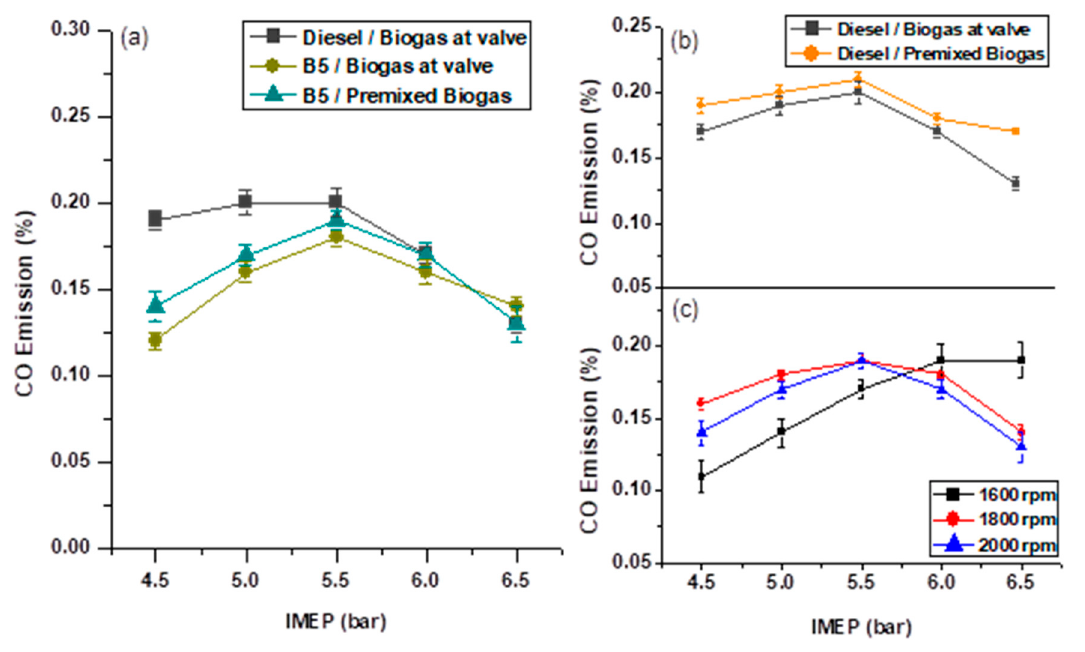
Figure 16. Engine-out CO emission for ( a ) B5 / biogas RCCI for premixed and port injection at the valve, ( b ) diesel / biogas in a premixed and port injection at the valve, and ( c ) B5 and premixed biogas RCCI combustion at various engine speed.